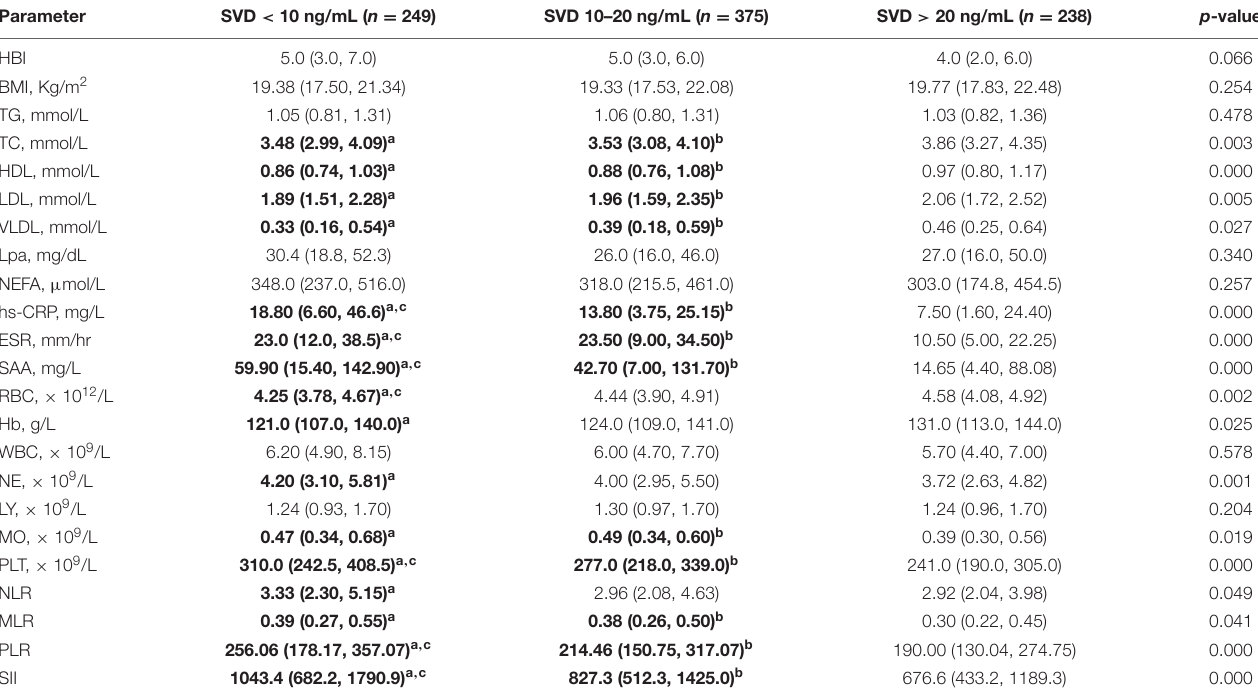
TABLE 3 | Parameter variables among different three vitamin D statuses in patients with Crohn’s disease. Parameter SVD < 10 ng/mL ( n = 249) SVD 10–20 ng/mL ( n = 375) SVD > 20 ng/mL ( n = 238) p -value